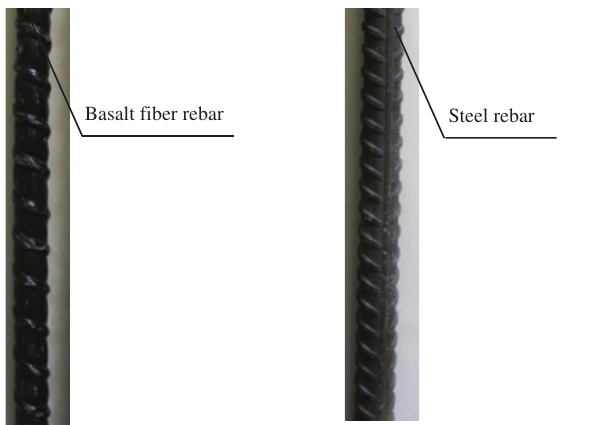
Figure 1: SEM image of LLFA used in this research.